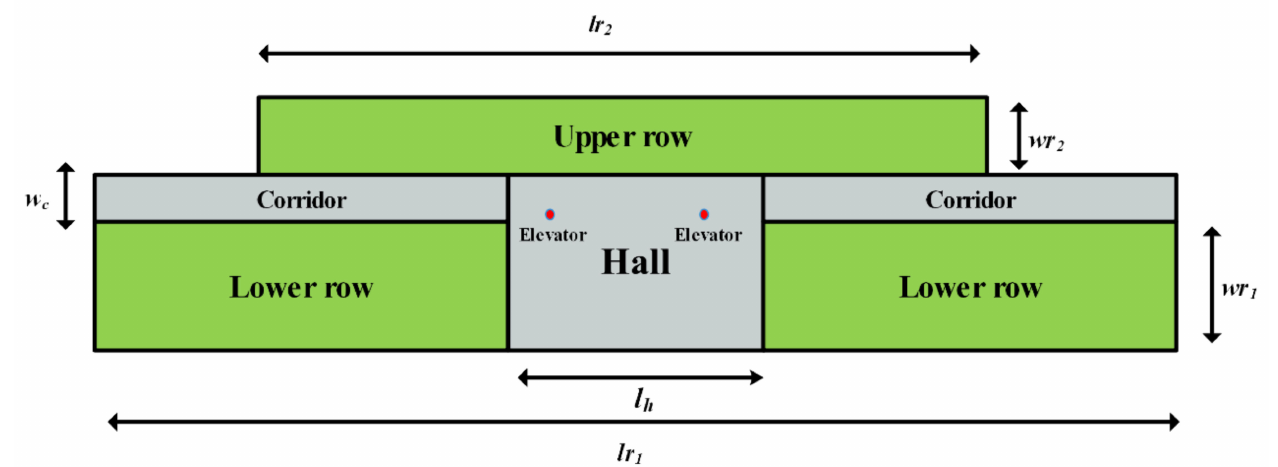
Figure 1. An empty floor